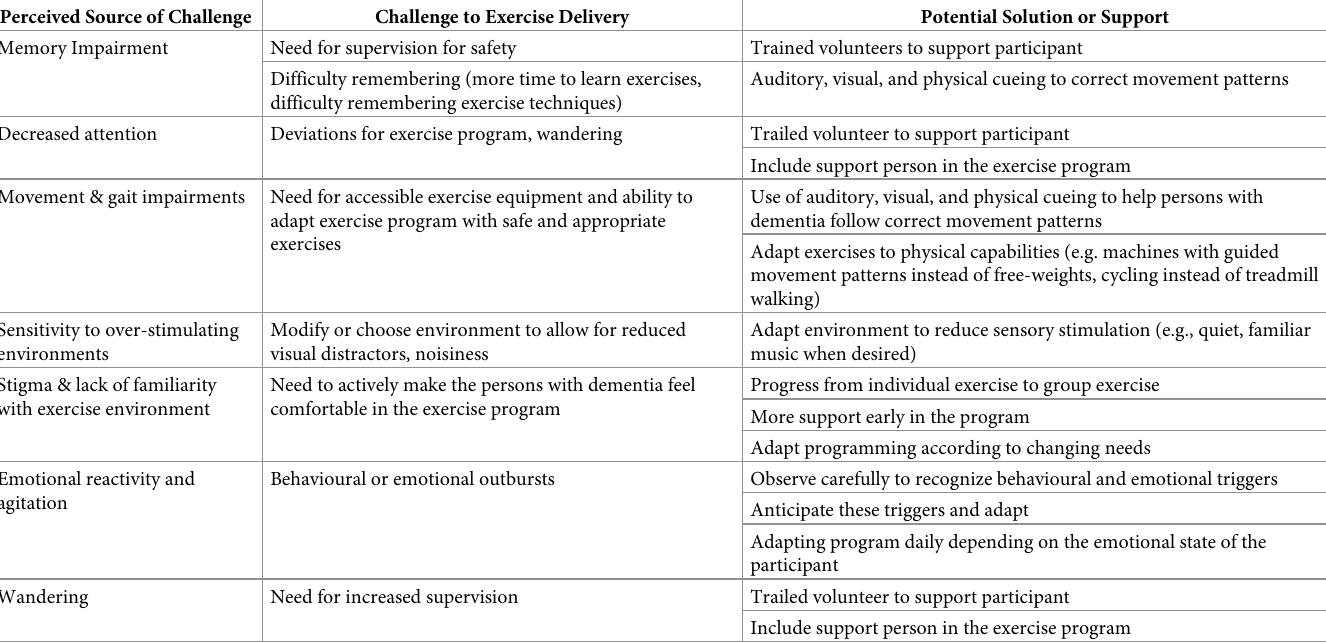
Table 2. Strategies used by exercise providers to accommodate individual-level barriers to exercise among persons with MCI or